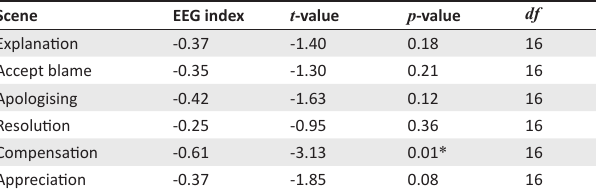
TABLE 4: Male respondents: More attractive female service provider.